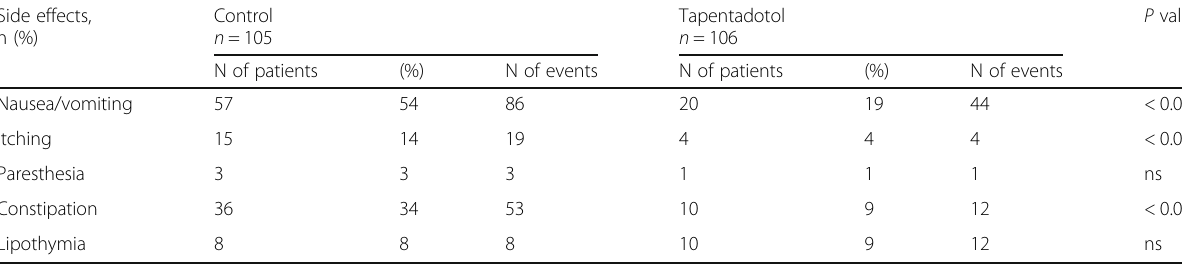
Table 2 Occurrence of side effects in the two treatment groups Side effects, n